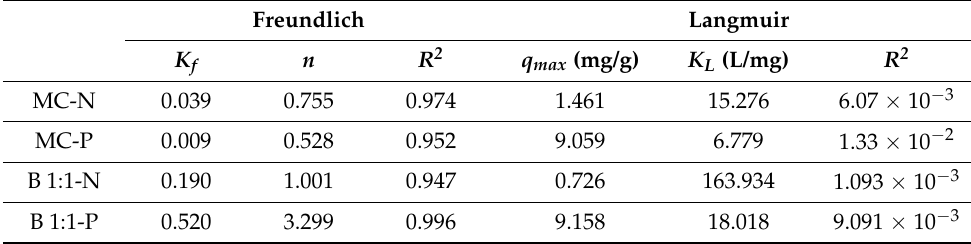
Table 3. Adjustment parameters of NO 3 − and PO 43 − adsorption linearized isotherms models. Freundlich